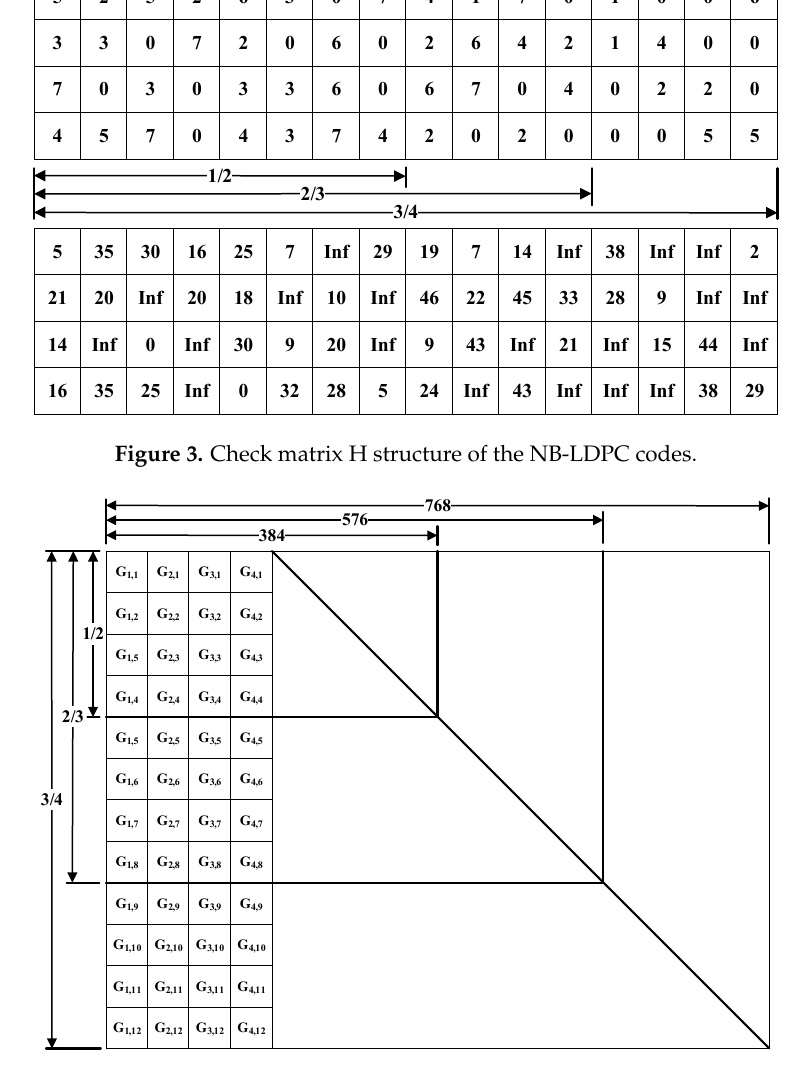
Figure 4. Generation matrix G structure of NB-LDPC codes.